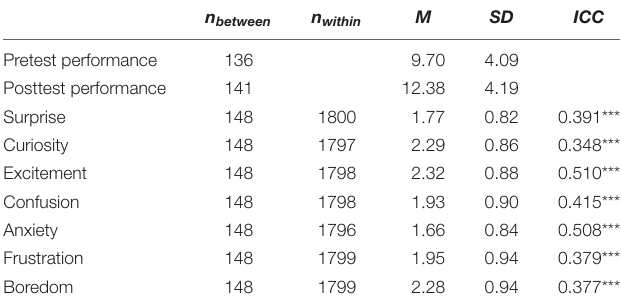
TABLE 1 | Descriptive statistics of the observed variables.